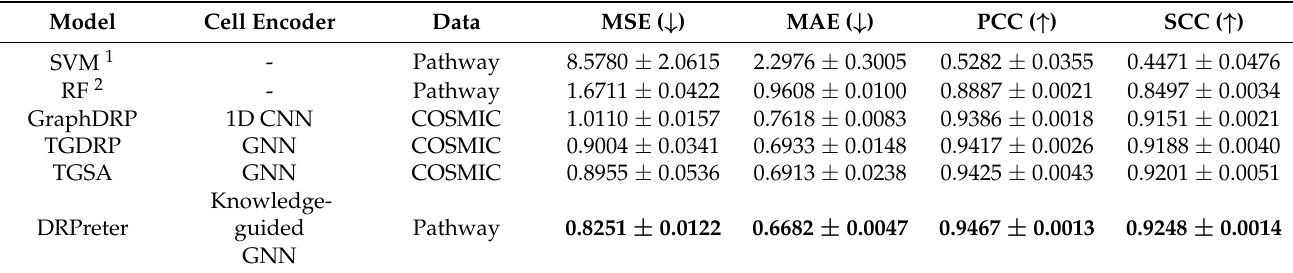
Table 2. Performance comparison with baseline models.